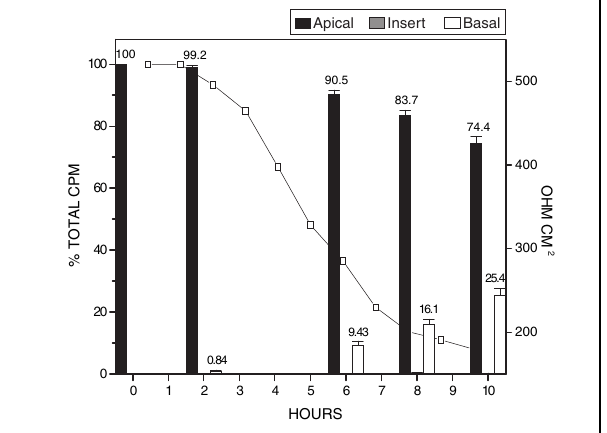
Figure 4) Radioactive count distribution for inserts treated with 125 I labelled toxin B. Inserts were inoculated with 500 µL of 125 I labelled toxin B (0.250 µg/mL). Samples from apical, basal and insert were tested for per cent of the total input counts per minute (cpm). The figure represents the average of three separate experiments. The elec- trical resistance measurements indicate the level of tight junction integrity. The total amount of radioactivity inoculated onto the insert in the form of radiolabelled toxin B was 7.0 × 10 3